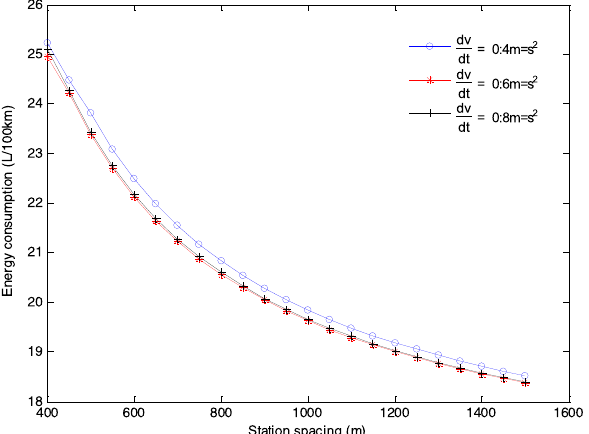
Figure 5. The lowest EC with different station spacings under different acceleration strategies.